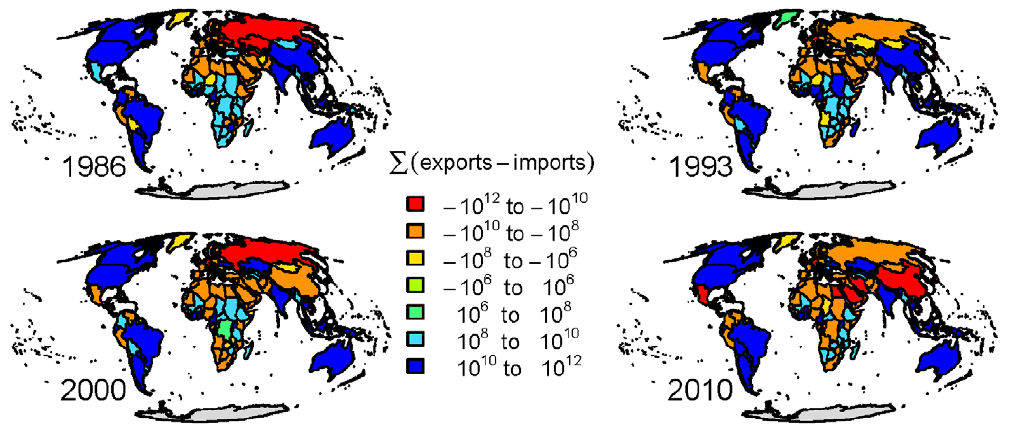
Figure 1. The virtual water import-export balance (m 3 ) for the years 1986, 1993, 2000 and 2010. The total flux along the network has more than doubled, and the number of nodes net importing has risen from 127 to 149 with a corresponding decrease in net exporters from 104 to 72. As such the ratio of net importers to exporters has changed from 1.2 to 2.0.